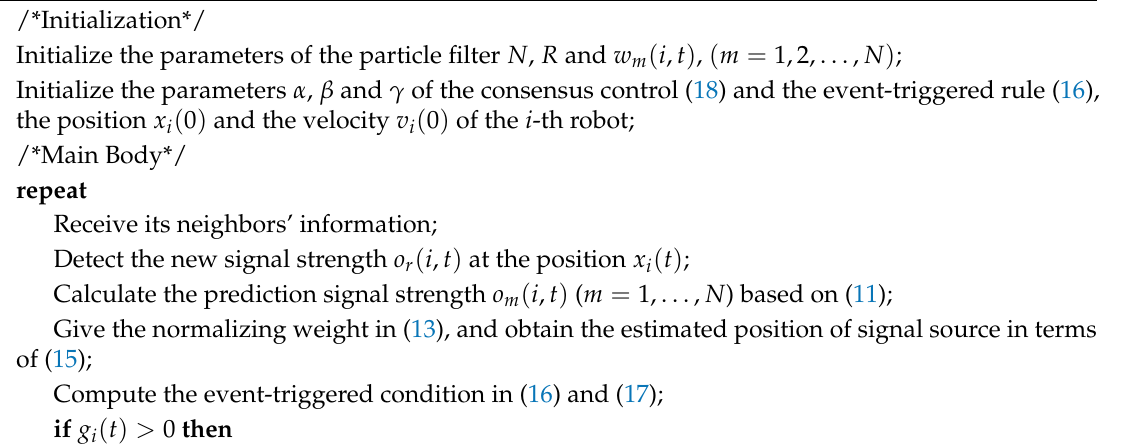
Algorithm 1 Decision-control approach with an event-triggered communication scheme.